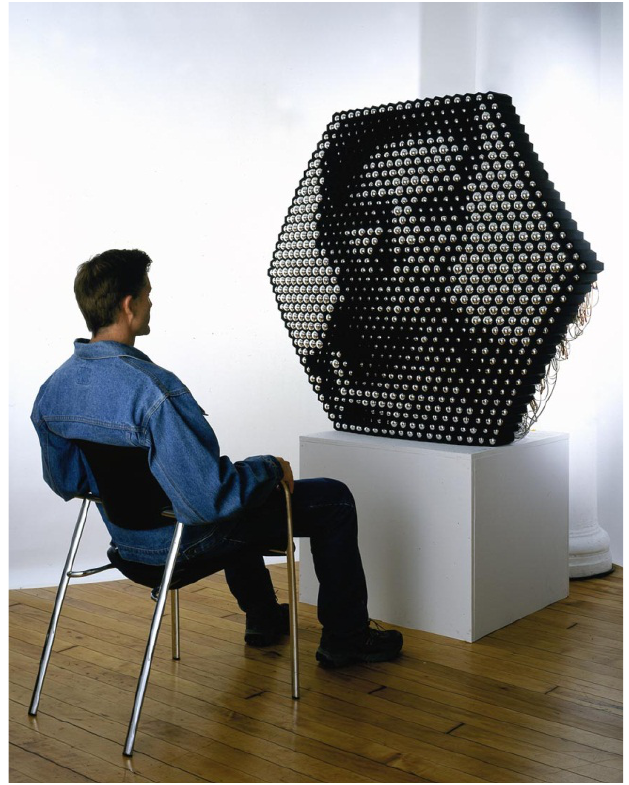
Figure 3. Shiny Ball Mirror, by Daniel Rozin